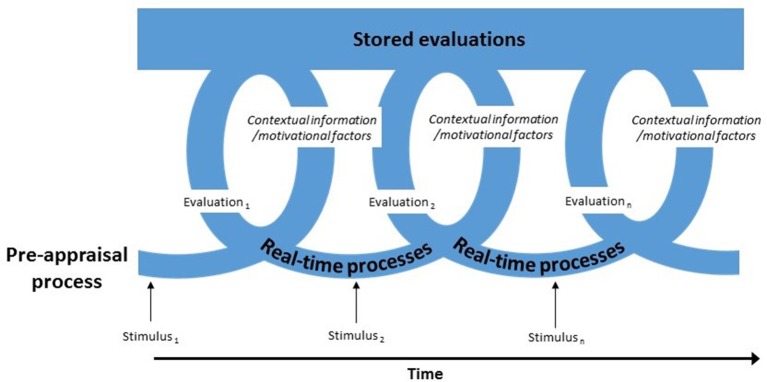
The Iterative Cycle of Evaluation (adapted from Cunningham and Zelazo, 2007).